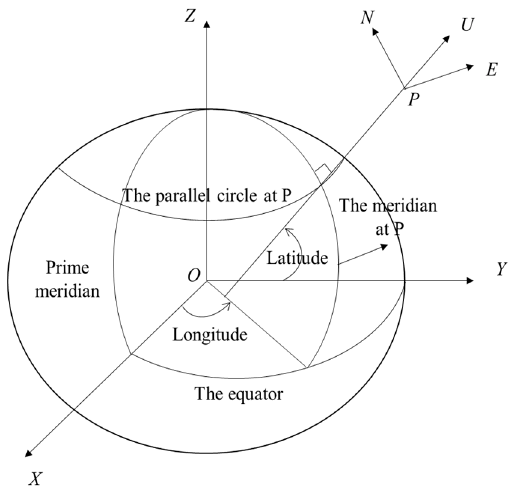
Figure 1. ECEF and ENU schematic